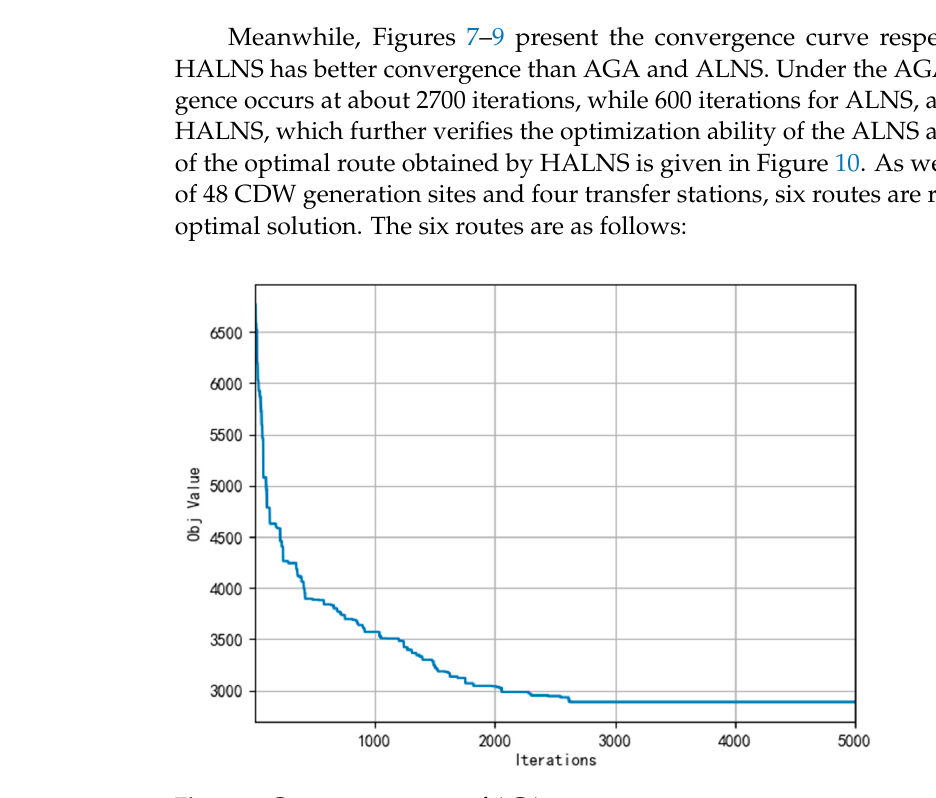
Figure 8. Convergence curve of ALNS.